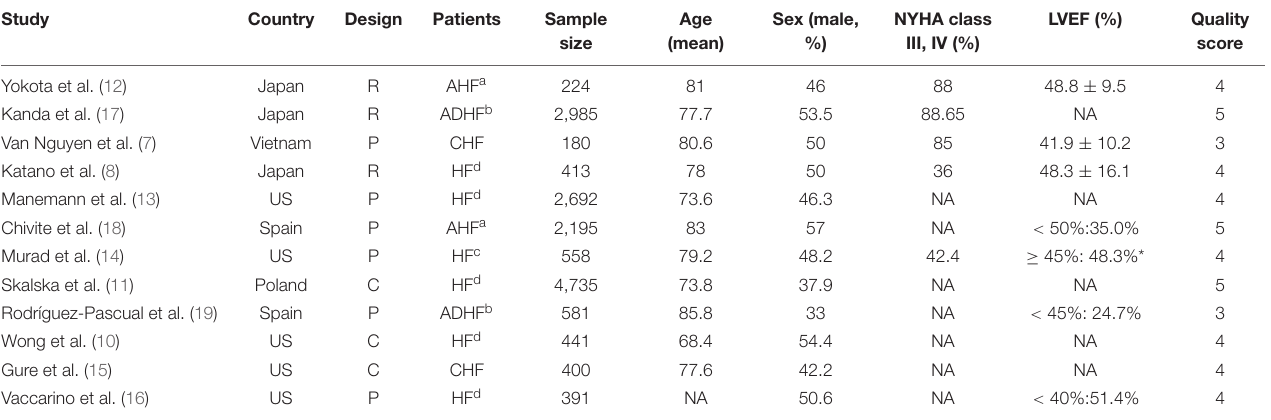
TABLE 1A | Characteristics of the included 12